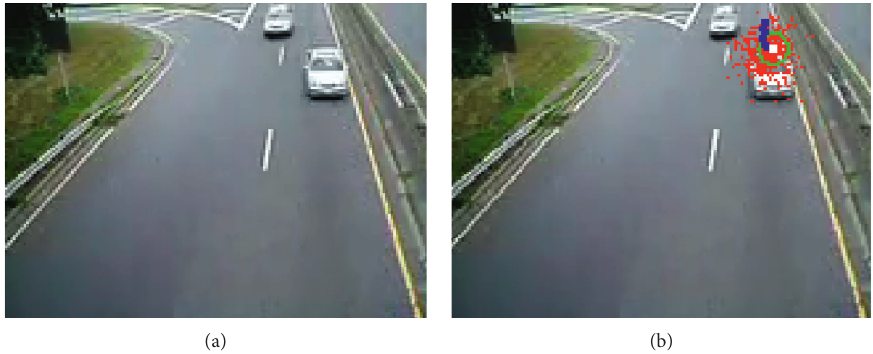
Figure 11: Tracking result of the 10 th frame. (a) The original image. (b) Tracked vehicle image.